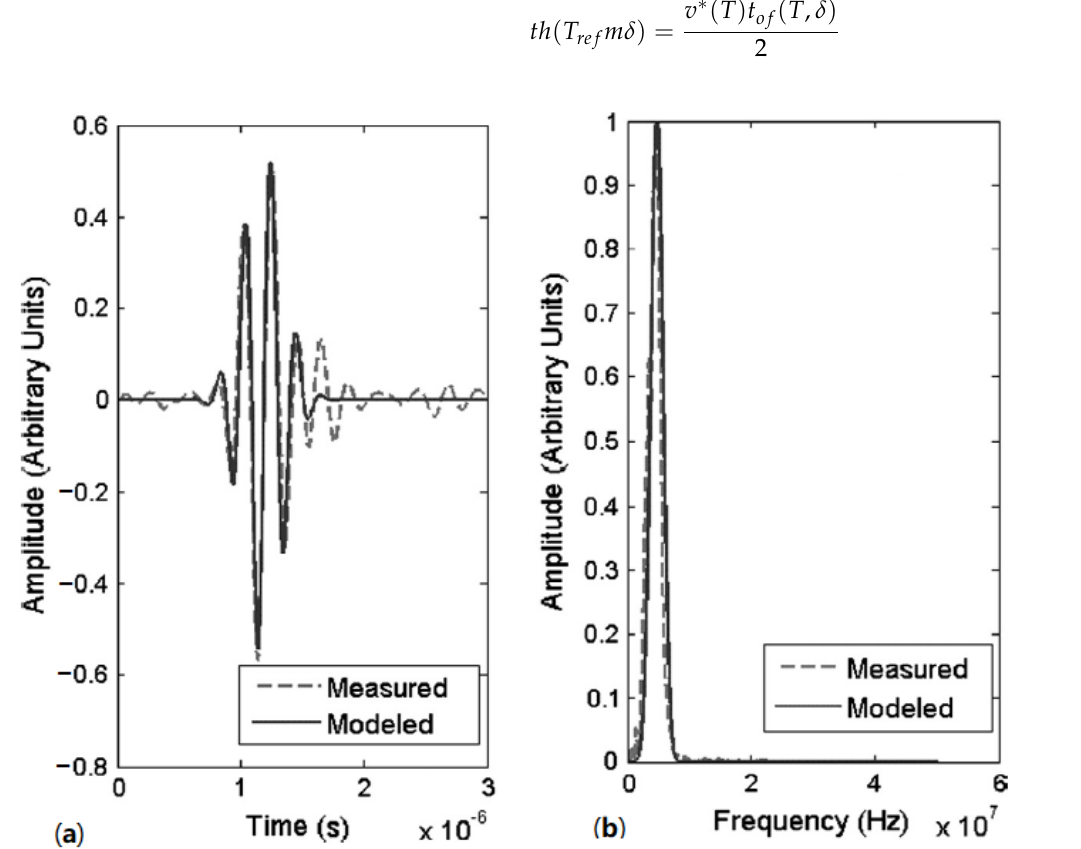
Figure 11. ( a ) The typical measured front wall echo and its corresponding Gaussian pulse. ( b ) The frequency spectra of the measured and modelled pulse. Reprinted from Ultrasonics, Volume 53, Honarvar, F.; Salehi, F.; Sasfavi, V.; Mokhtari, A.; Sinclair, A.N. Ultrasonic Monitoring of Erosion/Corrosion Thinning Rates in Industrial Piping Systems, Page 1251–1258, Year 2013 with permission from Elsevier